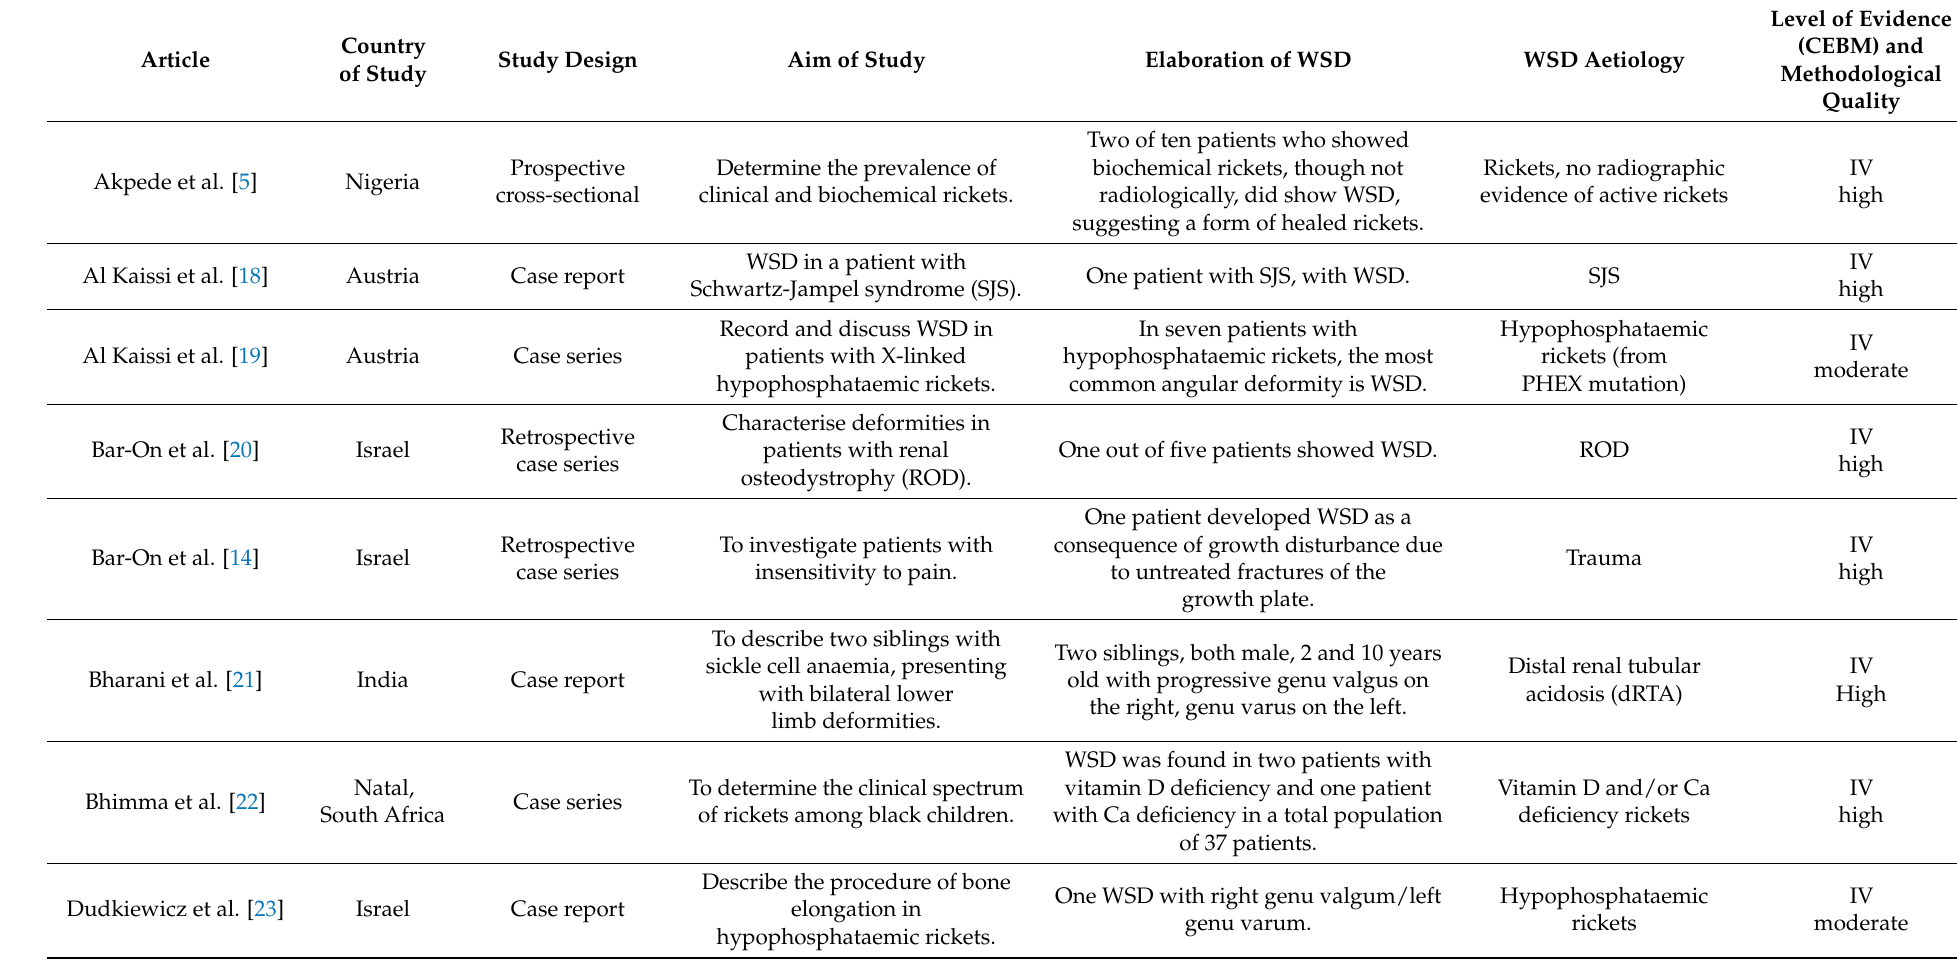
Table 1. Overview of the demographic data of all included studies regarding windswept deformity at the